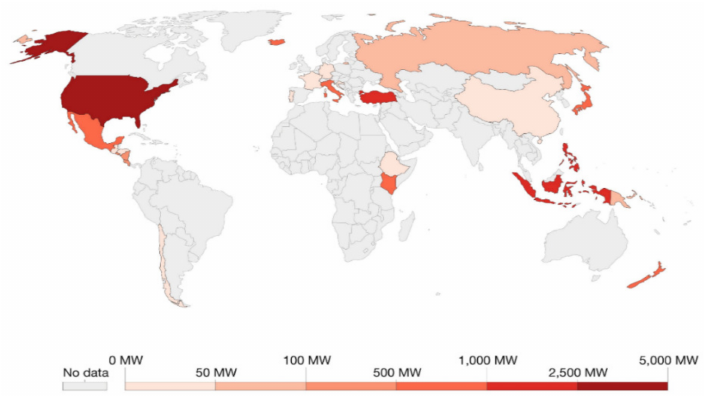
Figure 2. Geothermal energy capacity in 2020. Source: